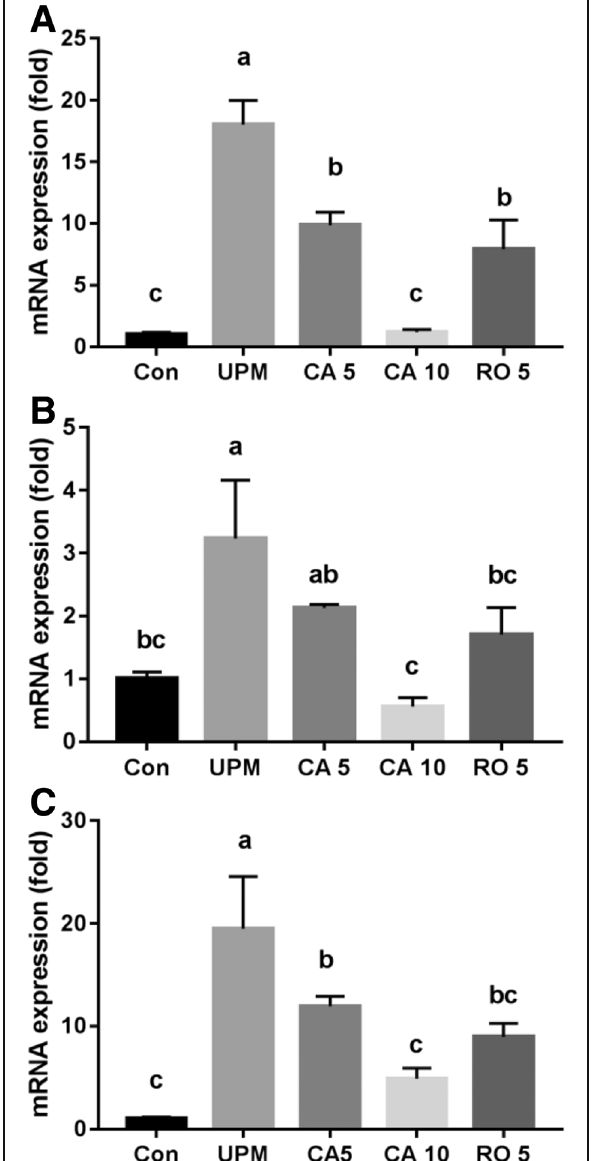
Fig. 3 Effect of CA on mRNA expression levels of inflammatory cytokines in the human pulmonary alveolar epithelial cells (NCI- H441) after treatment with UPM. a tumor necrosis factor- α (TNF- α ), ( b ) interleukin (IL)-6, and ( c ) IL-8 mRNA expression levels of NCI-H441 cells normalized to that of β -actin. After 24 h of pretreatment with CA (5 and 10 μ M), NCI-H441 cells were incubated with UPM (100 μ g/mL) for 6 h. Data are means ± SD of three experiments with triplicate samples and different letters indicate significant differences at p < 0.05 by Tukey ’ s multiple comparisons